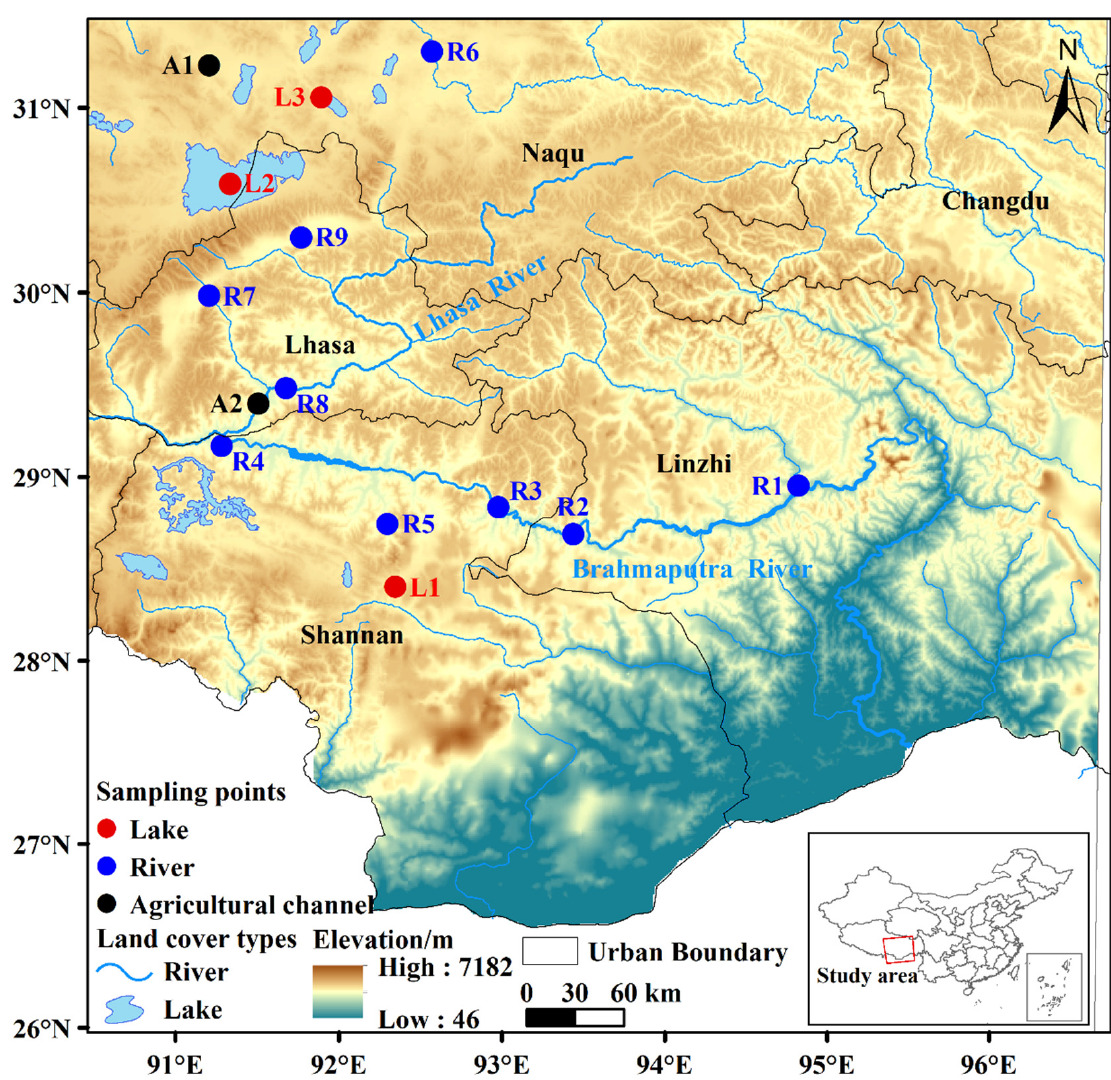
Figure 1. Locations of sampling sites in Tibetan Plateau.